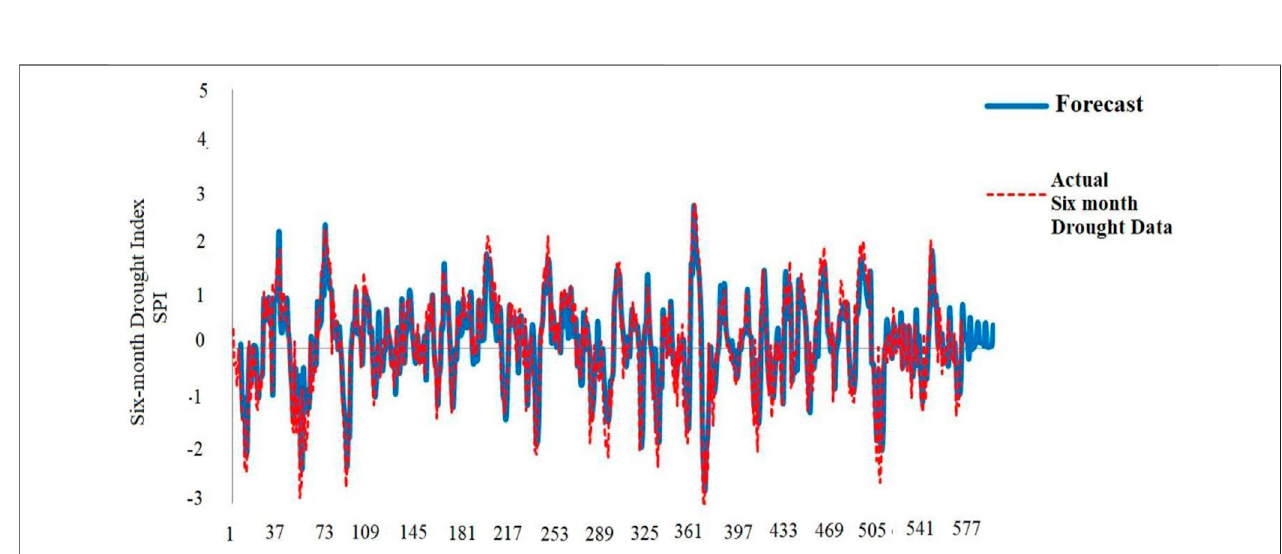
FIGURE 9 | Diagram of the selected model for forecasting drought index data.